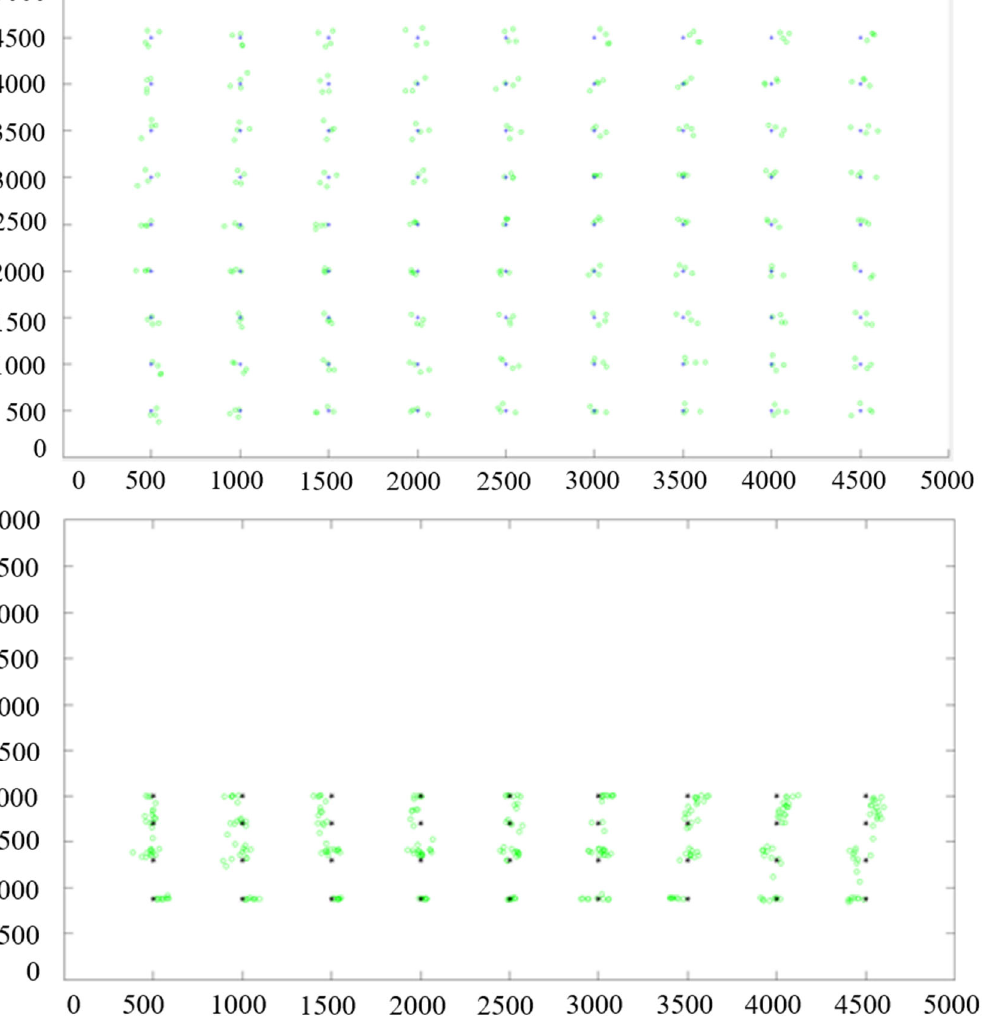
Figure 13. Schematic diagram of XOY and XOZ projections. ( a ) Comparison of theoretical coordinates and actual coordinates of target points in the XOY direction; ( b ) Comparison of theoretical coordinates and actual coordinates of target points in XOZ